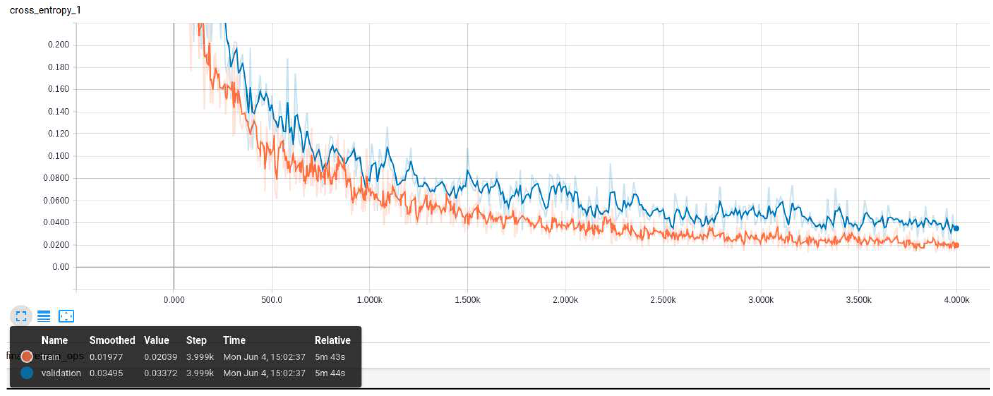
Figure 12. The entropy decreases during the training of our model, which can be considered a positive sign (the ambiguity reduces in our model).